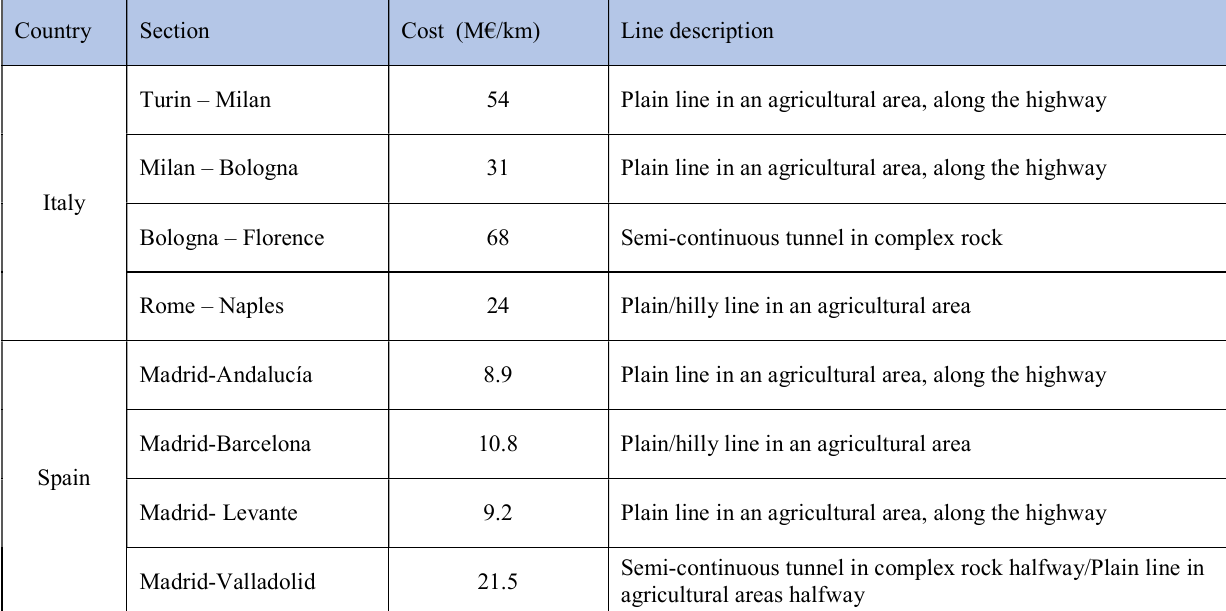
Table 1. The construction cost of HSR in Italy and Spain (in millions of euros per kilometer) [19]